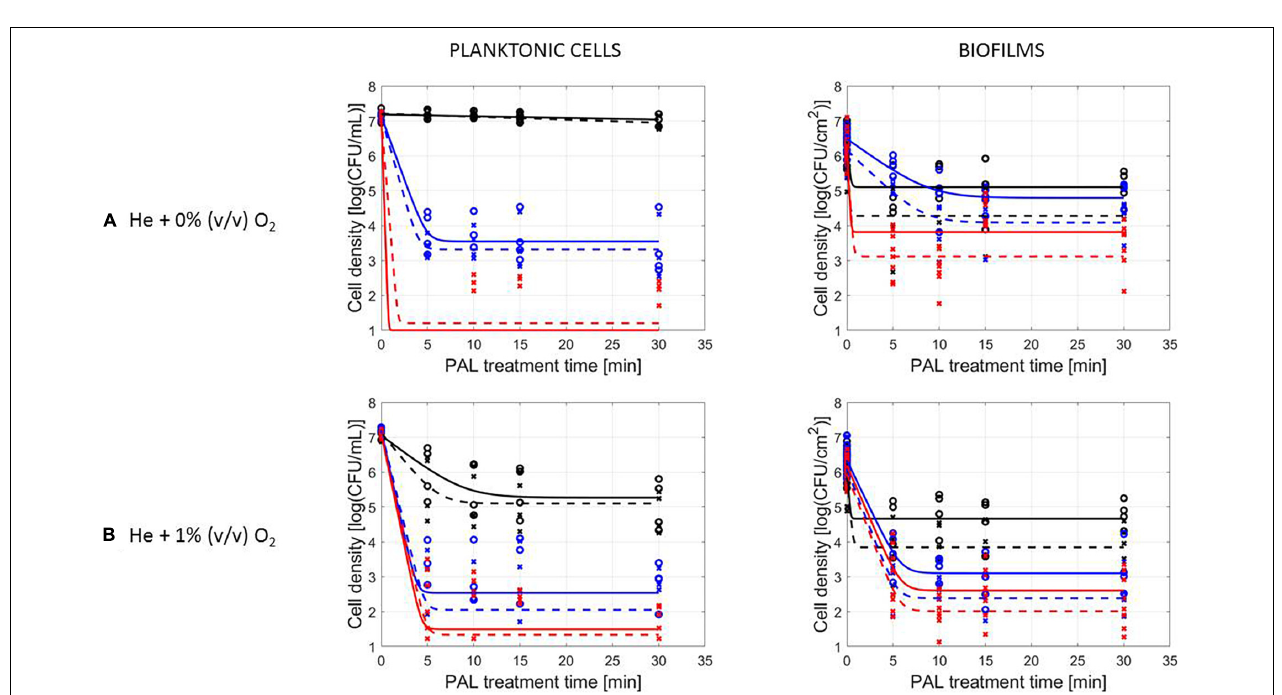
FIGURE 3 | Survival curves of S. Typhimurium planktonic cells and biofilms after plasma activated liquid treatment. Plasma activated liquids were created using two different cold atmospheric plasma gas compositions (A) He + 0% (v/v) O 2 or (B) He + 1% (v/v) O 2 , and three different generation times (10, 20, and 30 min). Experimental data (symbols) and global fit (line) of Geeraerd et al. (2000) model: total viable population (o, solid line) and uninjured viable population (x, dashed line).